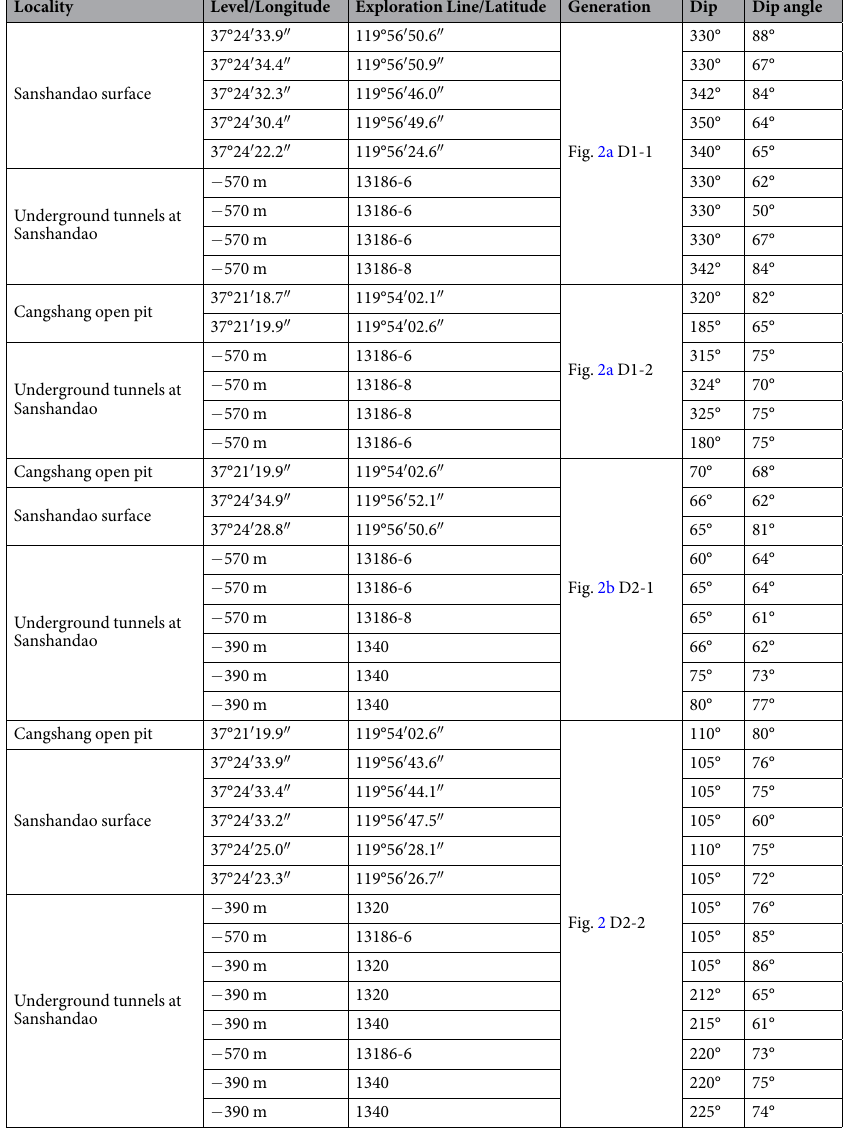
Table 2. A summary of the structural measurements in the Sanshandao - Cangshang